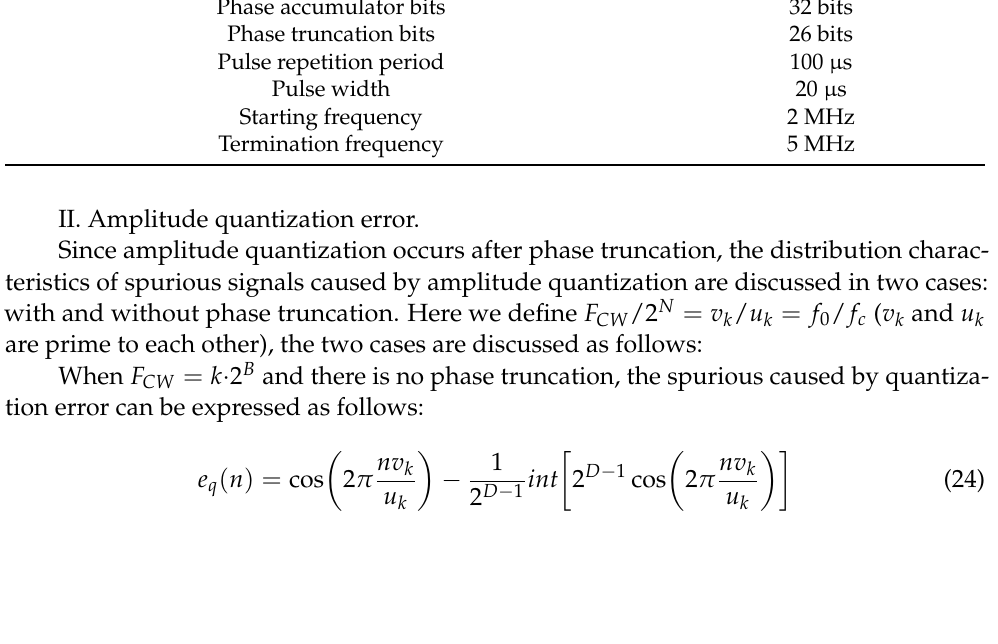
Table 2. Parameter of direct digital synthesizer.